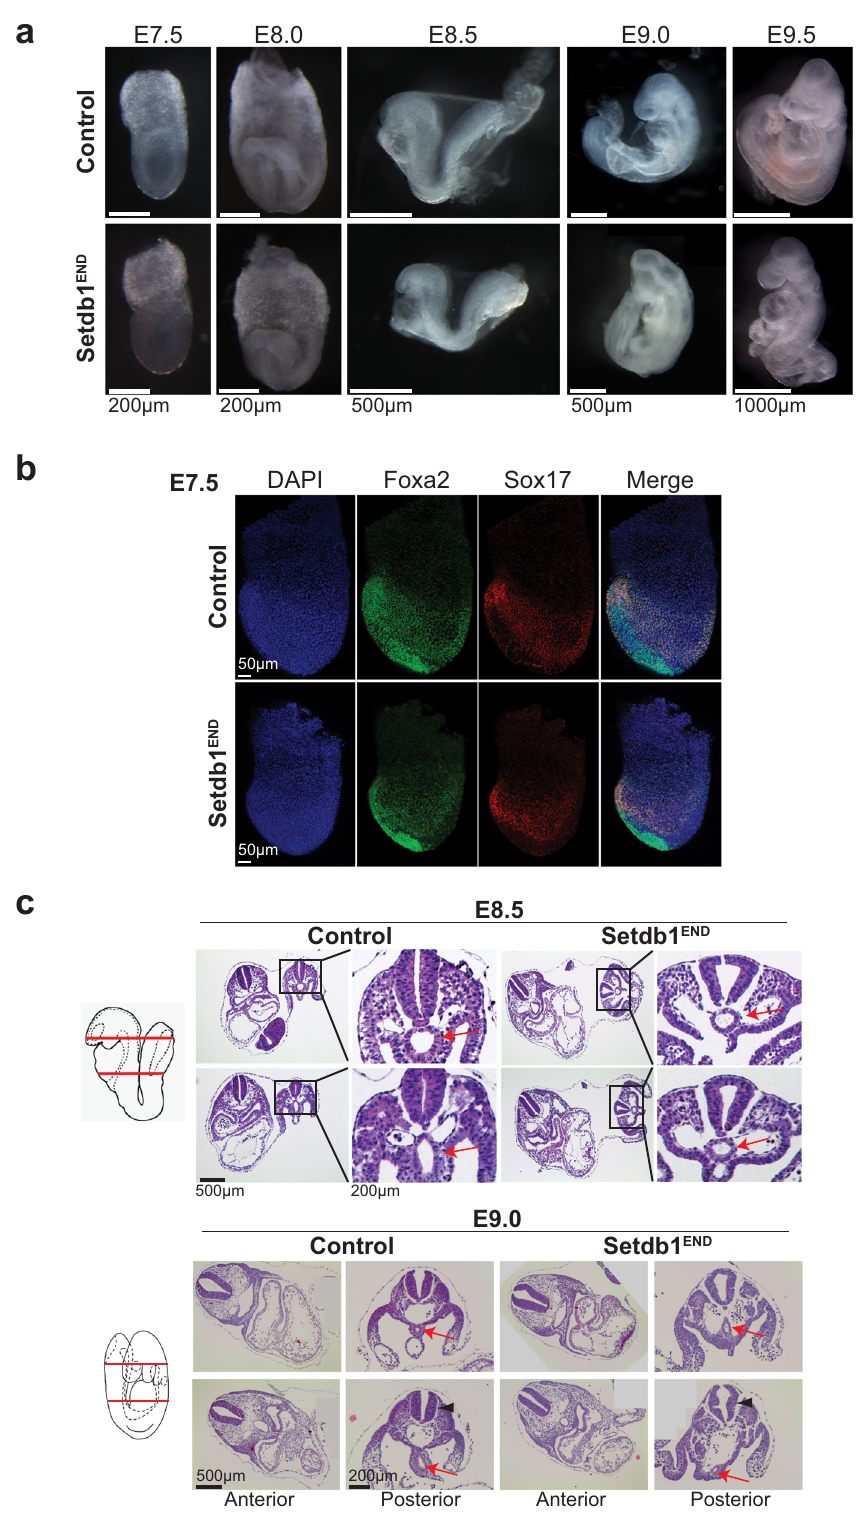
Fig. 1 | Loss of Setdb1 in endoderm leads to strong developmental defects during embryogenesis. a Lateral view of control and Setdb1 END embryos at E7.5 (late bud stage), E7.75 (head fold stage), E8.5 (~6 somite) and E9. No visible devel- opmentaldefectscanbedetectedinSetdb1 END embryosfromE7.5toE8.0.Setdb1 END embryosshowanaxisturningdefectwhichmanifestsfromE8.5andleadstostrong posterior truncation at E9.0. Representative images from n =3 per genotype and stage. b Lateral view of E7.5 control and Setdb1 END embryos stainedwith Foxa2 and